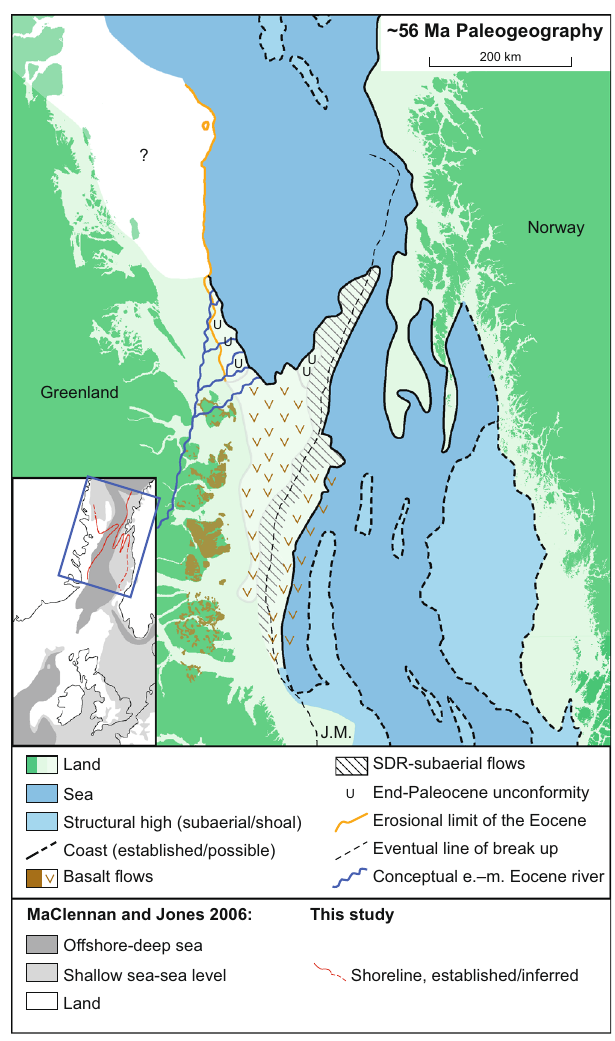
Fig. 4 Greenland – Norway Ridge during the Paleocene – Eocene transition. G-Plate reconstruction based on the poles of rotation and compilation of magnetic anomalies of Gaina et al. 25 with mapped volcanic facies and subaerial unconformities projected onto establish the distribution of land and sea. See the “ Methods ” section for detailed approach. The inset fi gure shows the paleogeography of the greater NGS region, which is modi fi ed and simpli fi ed from the uplift model of Maclennan and Jones 30 for the same time period. The data presented here revise the paleogeography of the main body of NGS. Instead of deep sea continuation towards the Barents Sea, the northern NGS was almost closed by a volcanic ridge at least until ~53 Ma. A narrow shallow-water strait may have existed between Greenland and